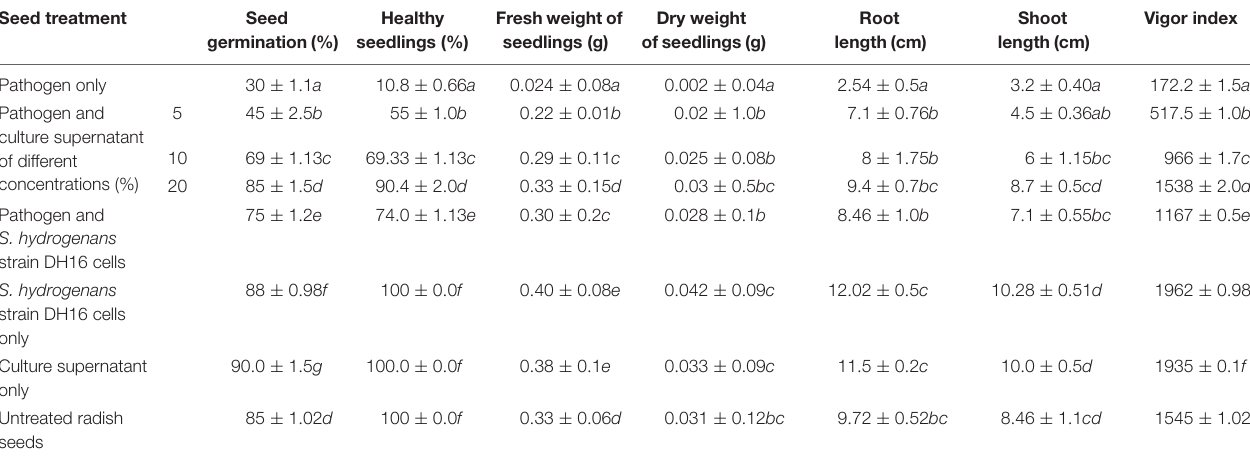
TABLE 2 | Effect of S. hydrogenans strain DH16 and its metabolites on seed germination, growth of seedlings and seedling vigor in R. sativus during in vitro blotter assays carried out for 7 days Seed